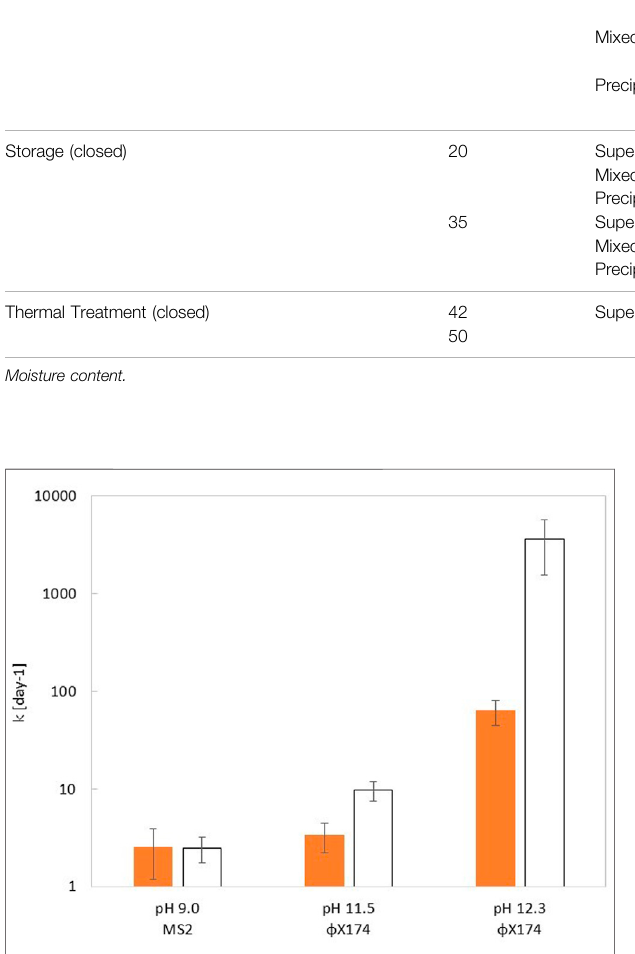
FIGURE 2 | Comparison of inactivation rate constant (k virus ) at 20 ° C measured within the feces (orange bar) or in a homogenous solution (white bar) of corresponding pH, for MS2 (pH 9.0) and Φ X174 (pH 11.5 and 12.3). Error bars depict the 95% CI determined from the fi t of the data to Eq. 3 . Inactivation curves for each experimental condition can be found in SI, Supplementary Figure S1 , and values of k virus are shown in Supplementary Table S2